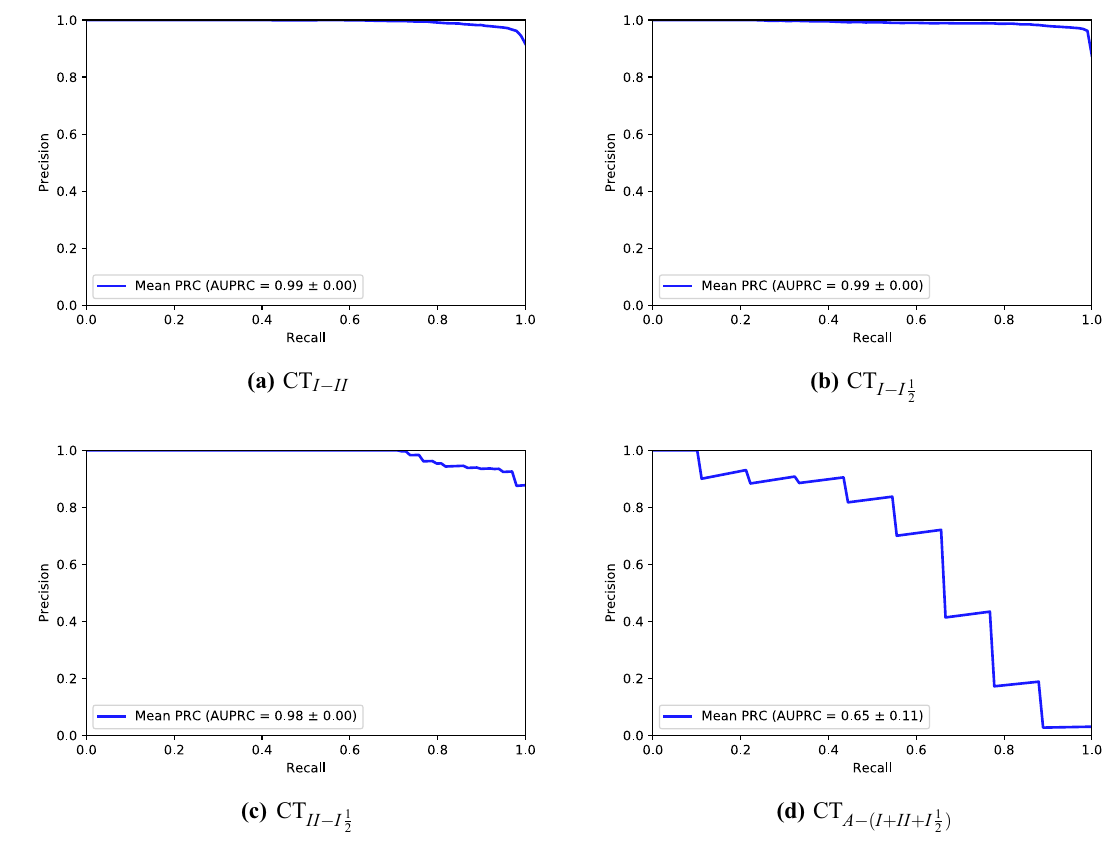
Figure 3. Average precision recall curves for the independent test sets in classification tasks. ( a ) CT I